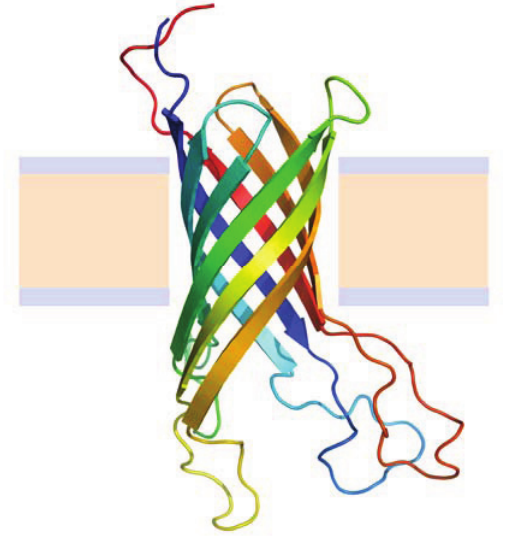
Figure 5. Structure of the Outer membrane protein A (OmpA) from E. coli (Protein Data Bank ID 1G90). Beta sheets are represented by arrows and protein loops are shown as thin lines. The beige area represents the hydrophobic core of the membrane, while the light-indigo regions refer to the hydrophylic head groups of